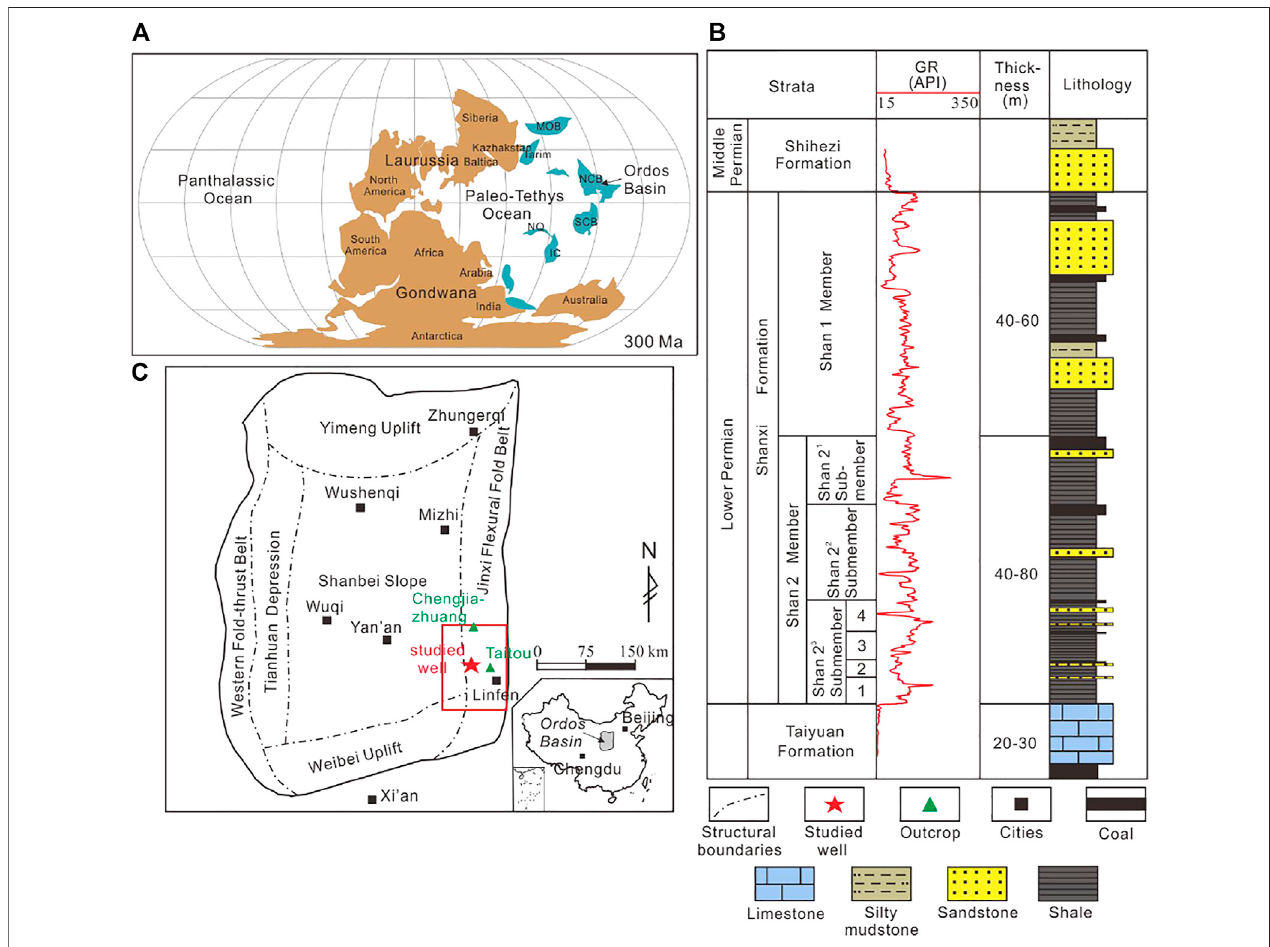
FIGURE 1 | (A) Paleogeographic reconstructions of the Eastern Asian blocks at 300 Ma with respect to the Ordos Basin. IC, MOB, NCB, NQ, Qm, and SCB indicate the Indochina, Mongolian, North China, North Qiangtang, Qaidam, and South China blocks/terranes, respectively, modi fi ed from Huang et al. (2018). (B) Location of the study area, North China. (C) Generalized stratigraphy of Shanxi Formation in the study area.